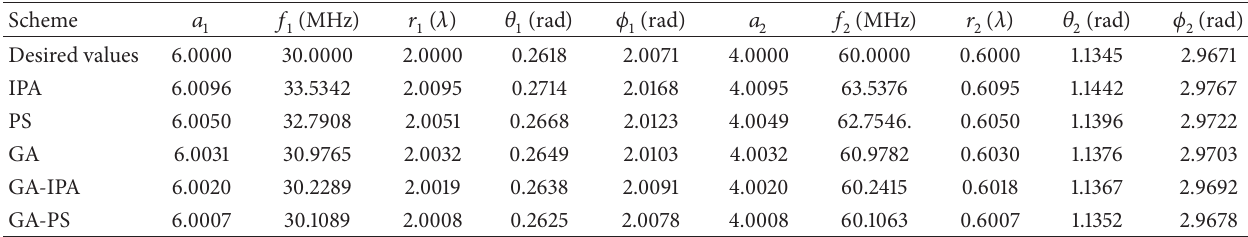
Table 2: Estimation accuracy of 2 sources using 9 sensors.